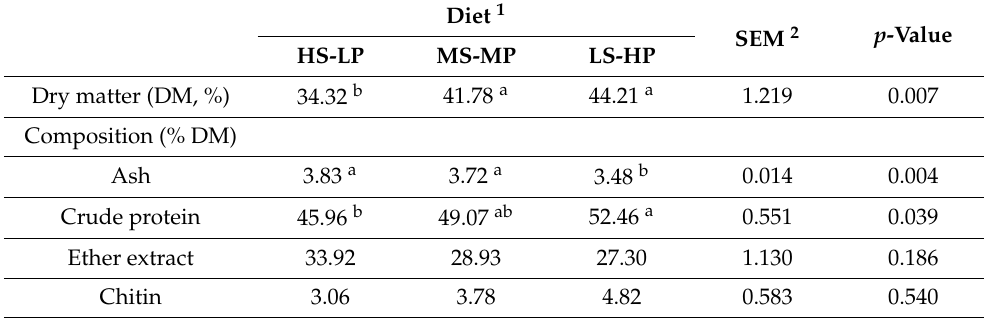
Table 4. Effects of the diets on the chemical composition of Tenebrio molitor larvae ( n = 5).